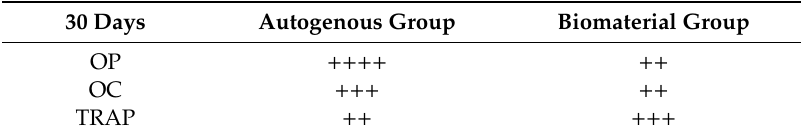
Table 2. Osteopontin (OP), Osteocalcin (OC), and Tartrate-resistant Acid Phosphatase (TRAP) immunostaining at 30 days for the experimental